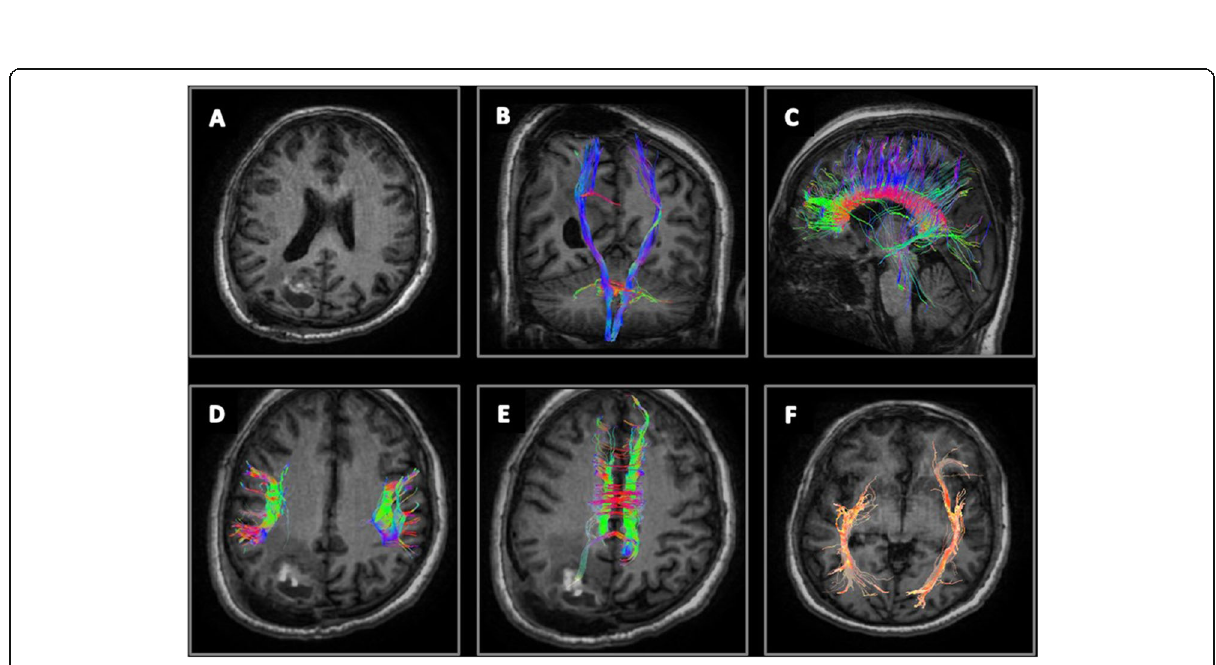
Fig. 6 Case number 3. a Postoperative axial T1 WI revealing a small right parieto-occipital residual with small hemorrhagic component surrounded by grade I vasogenic edema. b Coronal T1 WI with 3D reconstruction of the CST tracts revealing normalization of position and anisotropy of the intact right CST. c Sagittal T1 WI with 3D reconstruction of the CC tracts. d Axial T1 WI with 3D reconstruction of SLF revealing normalization of position and anisotropy. e Axial T1 WI with 3D reconstruction of the cingulum. f Axial T1 WI with 3D reconstruction of the ILF revealing normalization